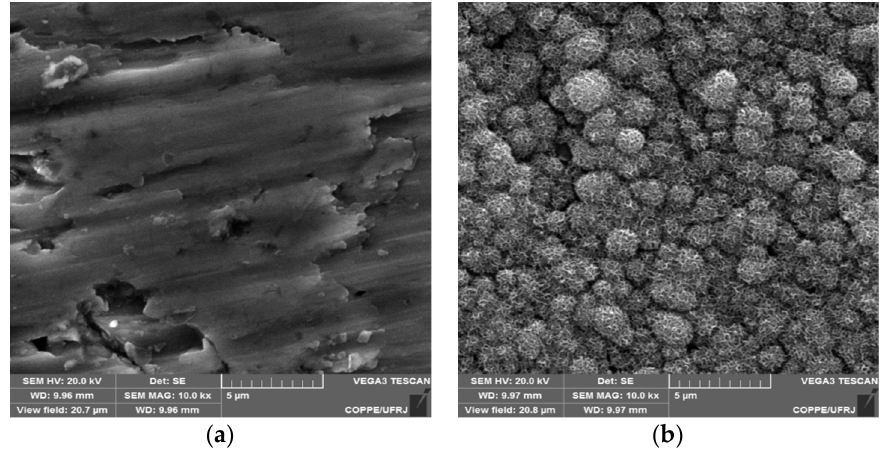
Figure 3. SEM images of samples’ surface after 14 days of bioactivity assaycomparing polished Ti without ( a ) and with alkaline hydrothermal treatment ( b ).